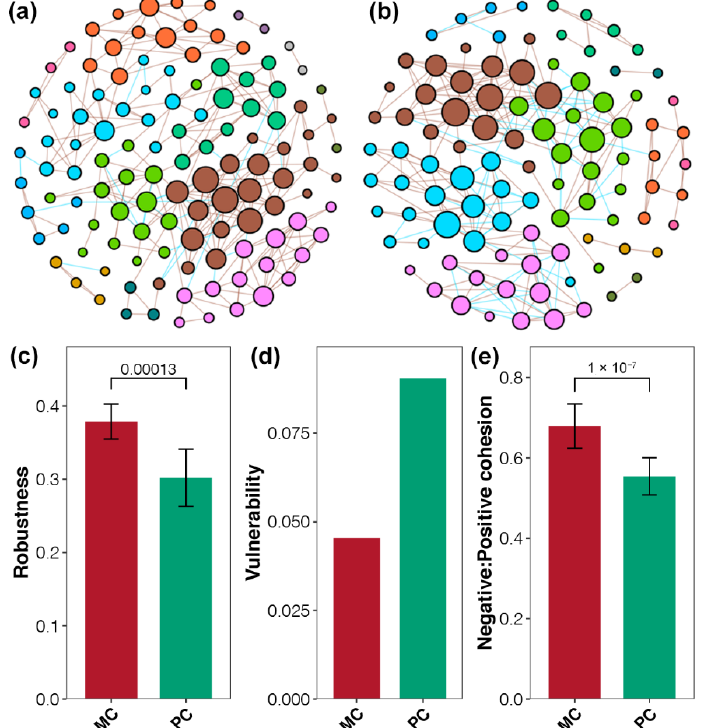
Figure 5. Community stability of bacterioplankton communities is affected by apex predators. ( a , b ) Molecular ecological networks of bacterioplankton communities in MC and PC ponds based on RMT analysis of OTU profiles. Modules are labeled in different colors in the respective networks. ( c – e ) Differences in robustness, vulnerability, and negative:positive cohesion between bacterioplank- ton communities in MC and PC ponds. Values on bars are p -values from Student’s t -tests between MC and PC